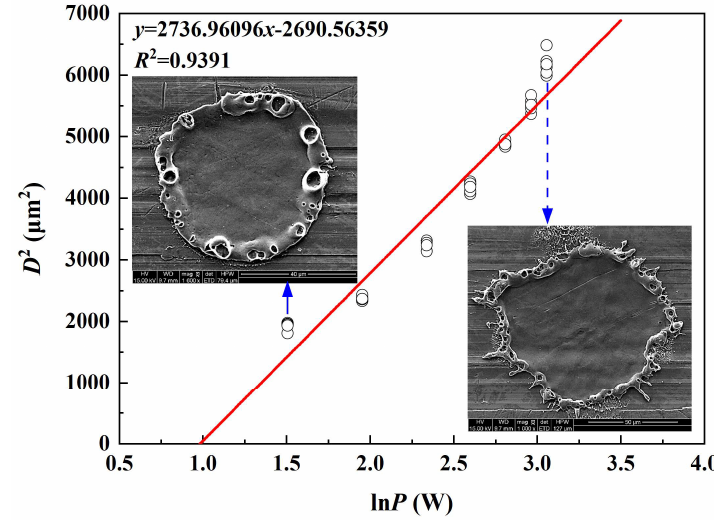
Figure 8. Squared diameters D 2 of the ablated craters are correlated with ln P .